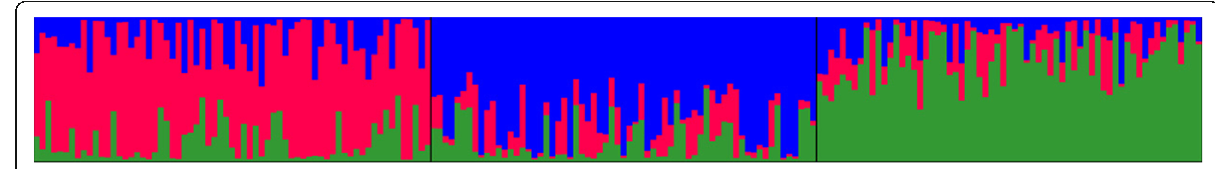
Fig. 2 Population structure: The bar plot of Q-matrix estimates for the accessions: Groups are represented in different colors (Red for Group 1, Blue for Group 2, Green for Group